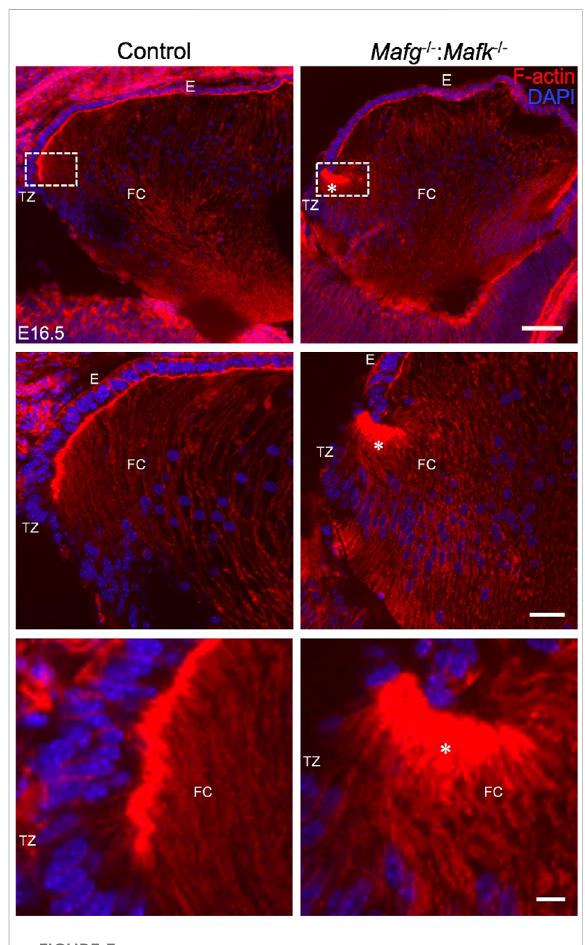
FIGURE 3 Mafg − / − : Mafk − / − mice exhibit abnormal F-actin distribution in differentiating lens fi ber cells. Staining with phalloidin for visualizing F-actin and co-staining with DAPI to visualize nuclei demonstrate that E16.5 Mafg − / − : Mafk − / − mice exhibit non- uniform distribution (asterisk) of F-actin at the apical tips of the fi ber cells near the transition zone. The area shown in the broken- line box in control and test was used for measurement of fl uorescence signal intensity shown in Figure 4B. Abbreviation: E, Epithelium of the lens; FC, Fiber cells of the lens; TZ, Transition zone of the lens. Scale bar for Row 1, 20 μ m; Row 2, 10 μ m; Row 3, 8 μ